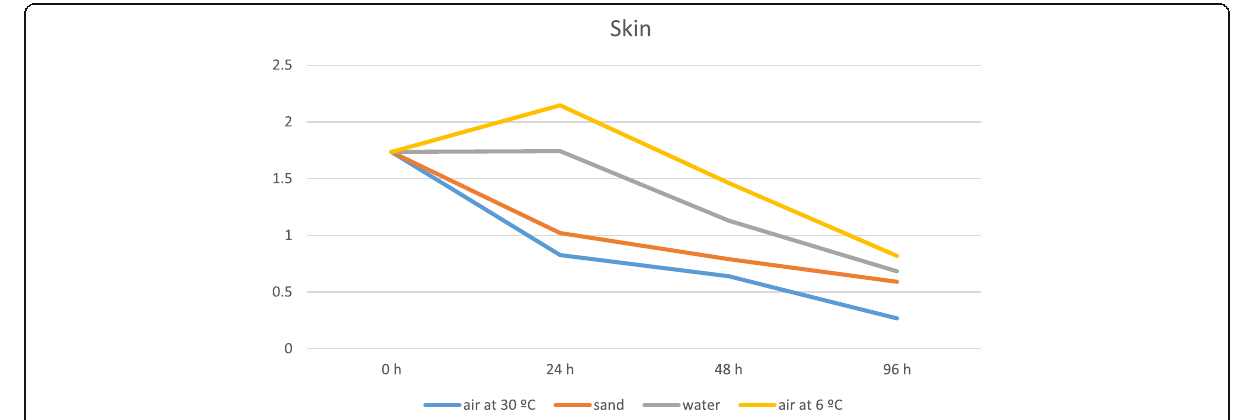
Fig. 1 Mean skin GAPDH relative expression levels in the studied groups after different time intervals